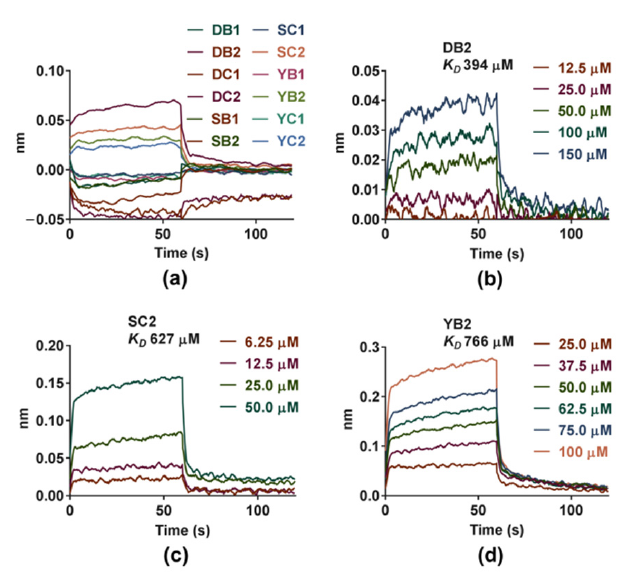
Figure 2. Sensograms for the interaction of 12 compounds with cyclooxygenases 2 (COX2) obtained with biolayer interferometry (BLI); ( a ) All 12 compounds were initially assayed at a single concentra- tion of 100 µ M. ( b – d ) The results showed a medium-high affinity of compounds DB2 ( b ), SC2 ( c ) and YB2 ( d ) to COX2.